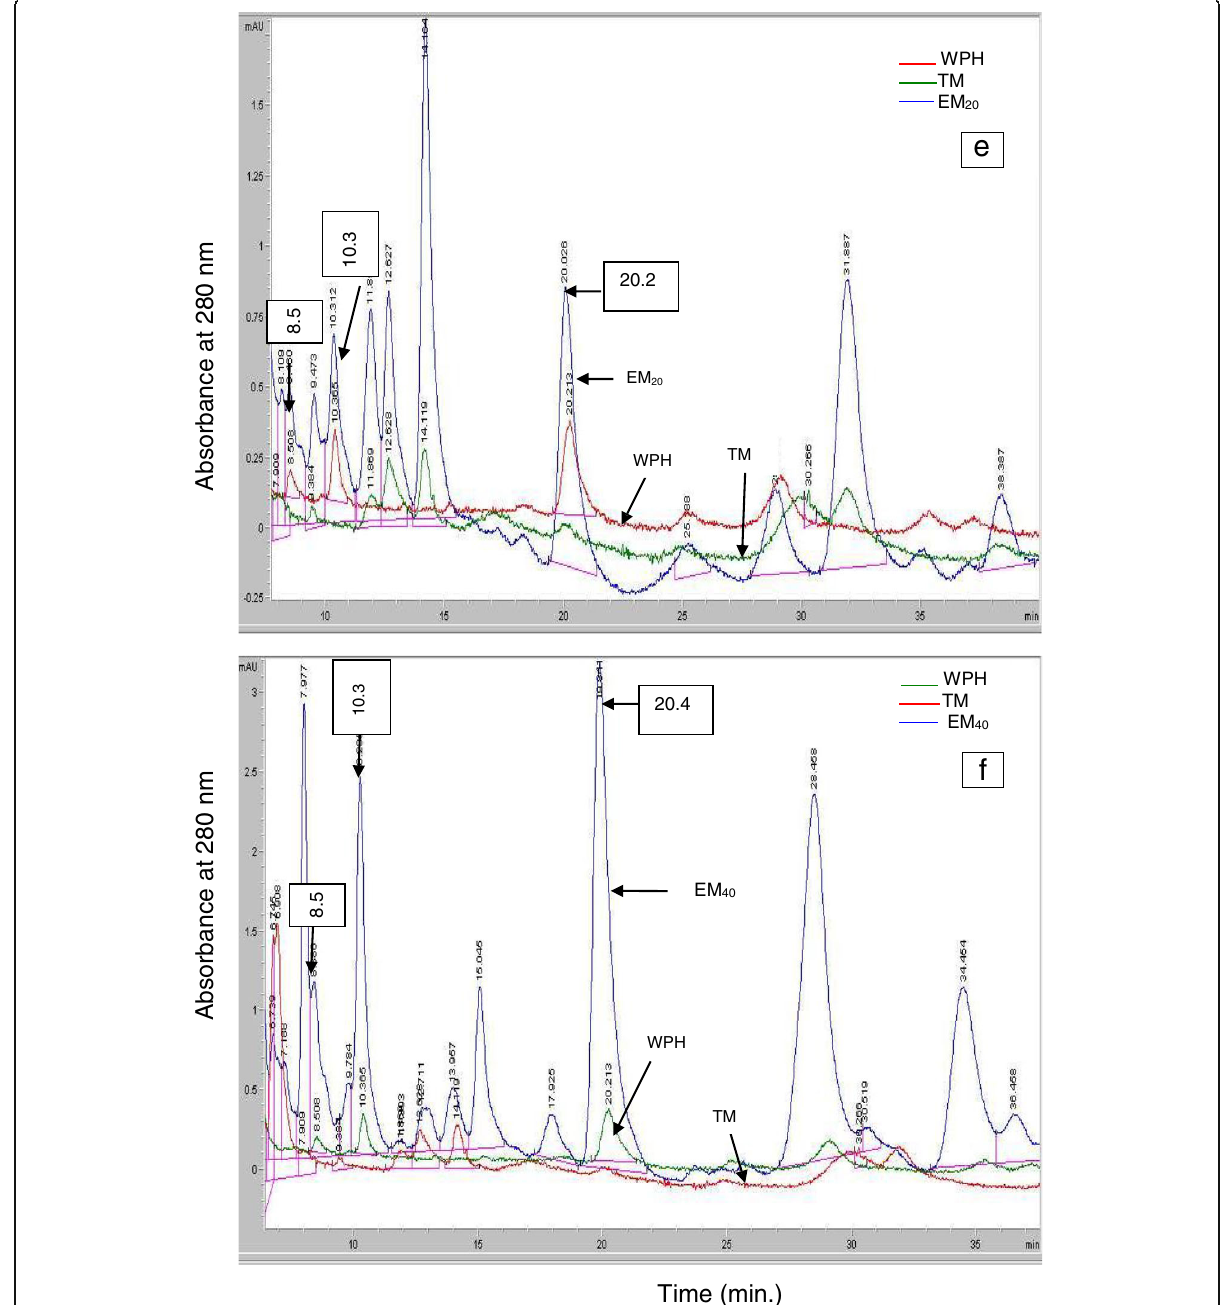
Fig. 4 e RP-HPLC profile of whey proteins and peptides in WPH, toned milk and enriched milk with 20% (v/v) hydrolyzate (EM 20 ) and f 40% (v/v) hydrolyzate